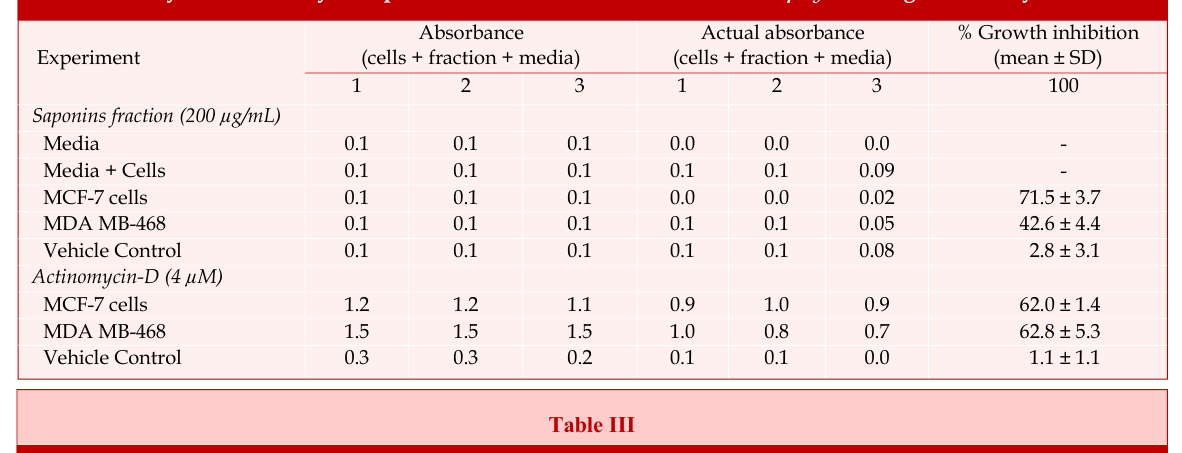
Cytotoxic activity of saponins fractions from Gaultheria trichophylla using MTT assay